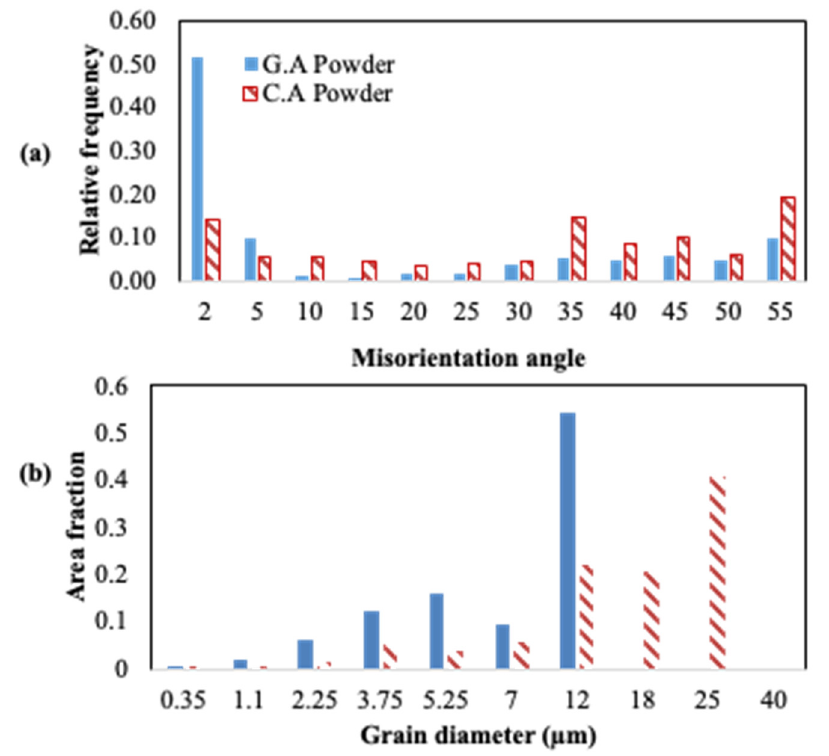
Figure 9. Total misorientation ( a ) and grain size distribution ( b ) obtained from the G.A and C.A powder EBSD scans.